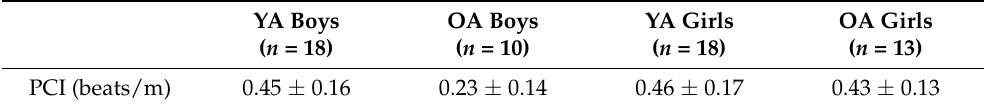
Table 3. The physiological cost index values for the four groups.